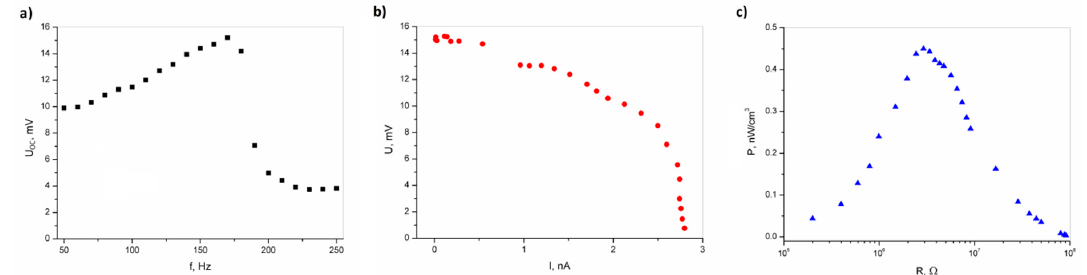
Figure 4. ( a ) Output voltage of an open circuit of epoxy resin/SbSI nanowire generator, registered for varying frequencies of sound excitation; ( b ) output voltage of epoxy resin/SbSI nanowire generator vs current intensity, registered for different load resistances ( f = 170 Hz; L = 90 dB); ( c ) power density calculated for the volume of an epoxy resin/SbSI nanowire generator, as a function of load resistance with sound excitation ( f = 170 Hz; L = 90 dB).